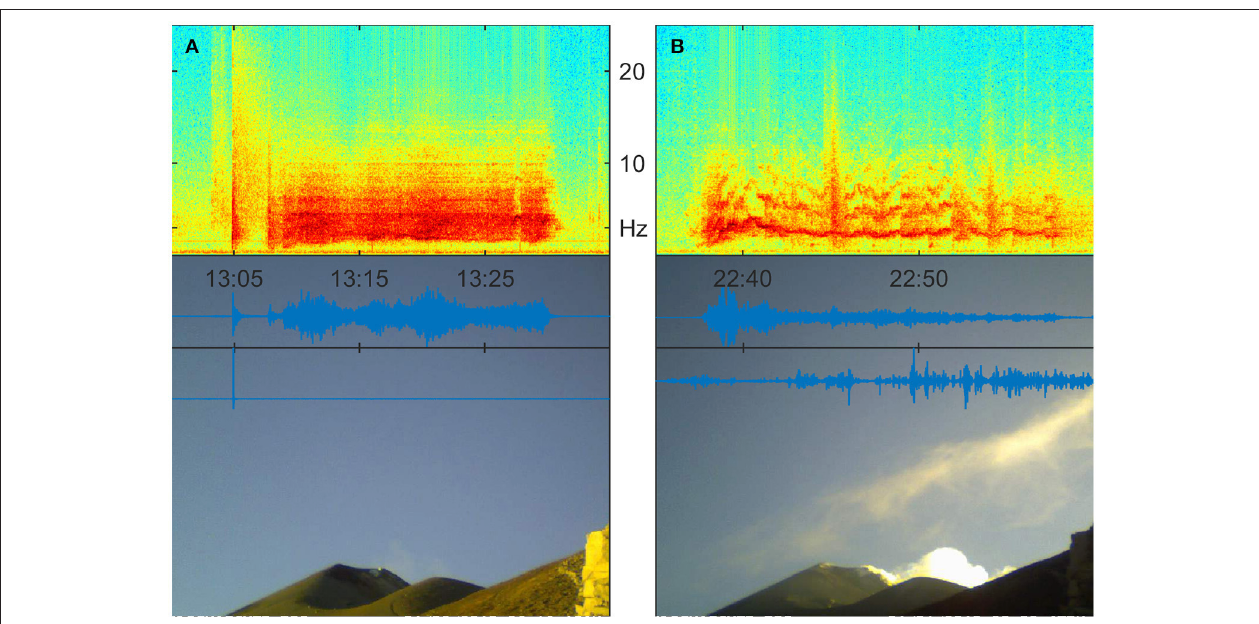
FIGURE 7 | Examples of (A) broadband tremor and (B) harmonic tremor recorded at station NE1 plotted together with images from the time-lapse camera that was located near the seismic station. The spectrogram of the vertical component is plotted above the trace of the same time. The lowest trace is from a collocated infrasound sensor. Trace units are